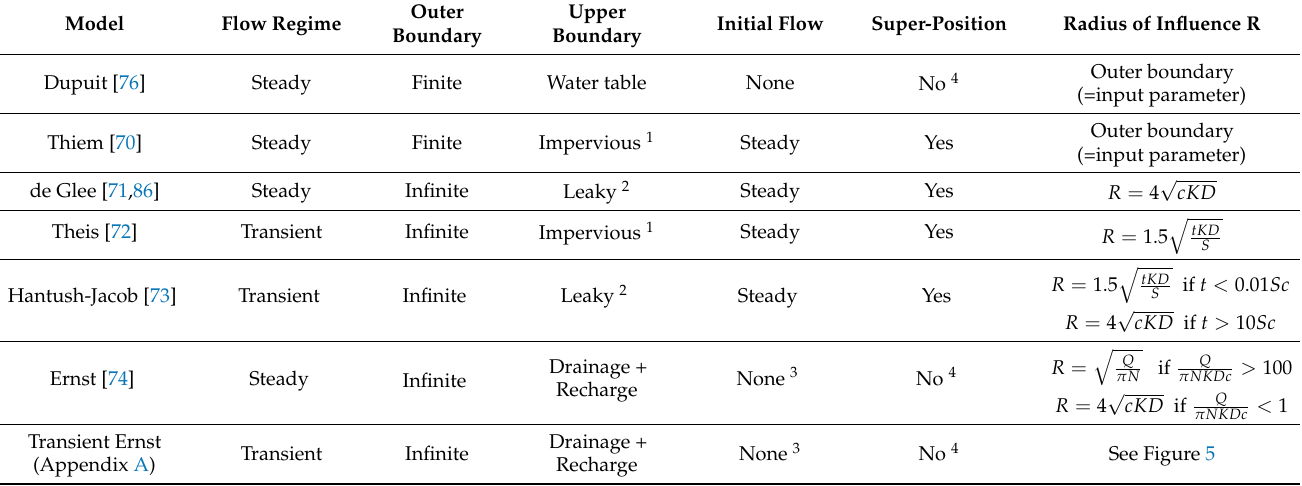
Table 1. Summary of the analytical models discussed in the paper applied to simulate axisymmetric flow towards a fully penetrating well with infinitesimal radius and constant pumping rate in a homogeneous aquifer with impervious base. From the solutions of these models, equations and rules of thumb are derived to estimate the radius of influence R , with KD the transmissivity, c the resistance, S the storage coefficient, N the infiltration flux, Q the pumping rate, and t the time. See text for explanation and